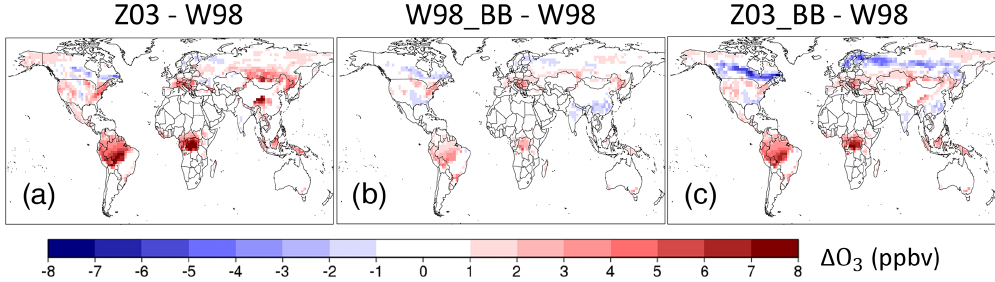
Figure 4. Estimated difference in July mean surface ozone ( (cid:49) O 3 ) due to the discrepancy of simulated July mean daytime v d among the parameterizations.